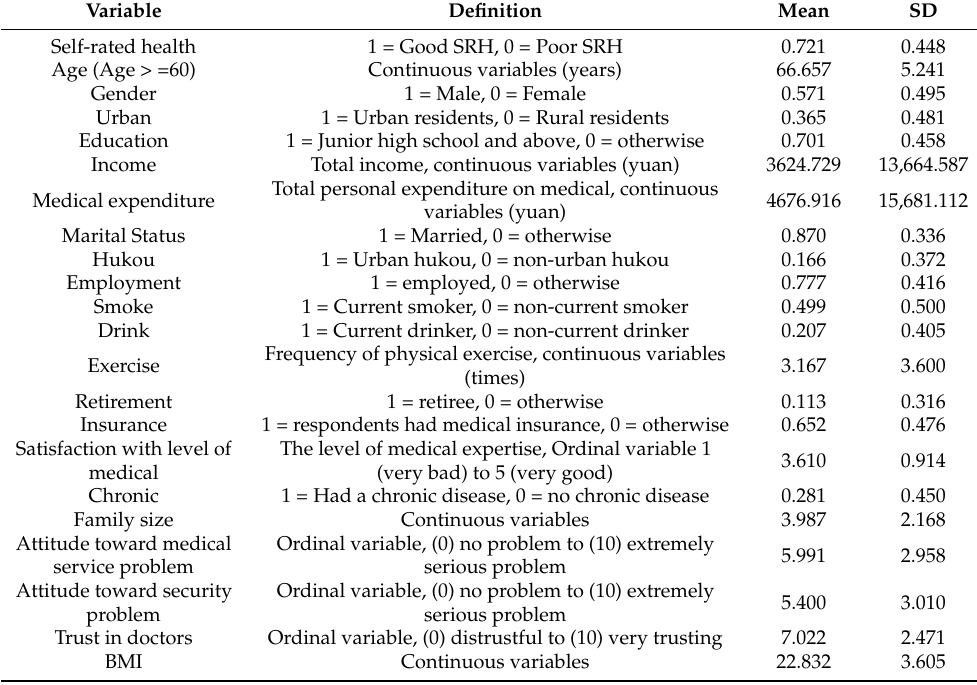
Table 1. Baseline factors examined in this study. SD: standard